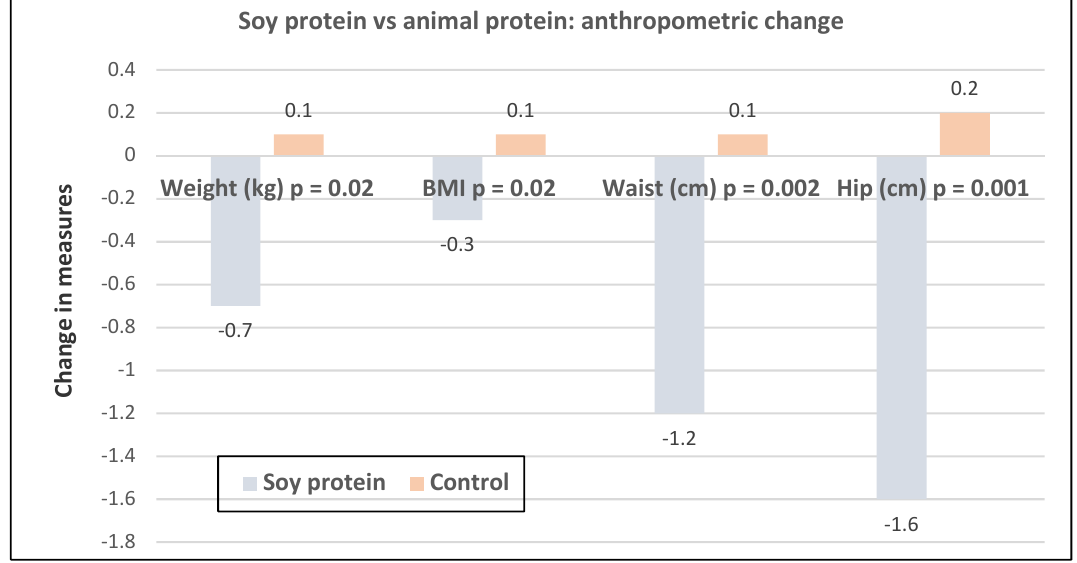
Figure 21. Change in anthropometric measures in 60 women with polycystic ovary syndrome (mean age 25 years and BMI 28) consuming isocaloric diets with 0.8 g protein per kg from soy group (35% soy protein, 35% animal protein and 30% plant protein) vs. non-soy control (70% animal protein and 30% vegetable protein) for eight weeks [61].